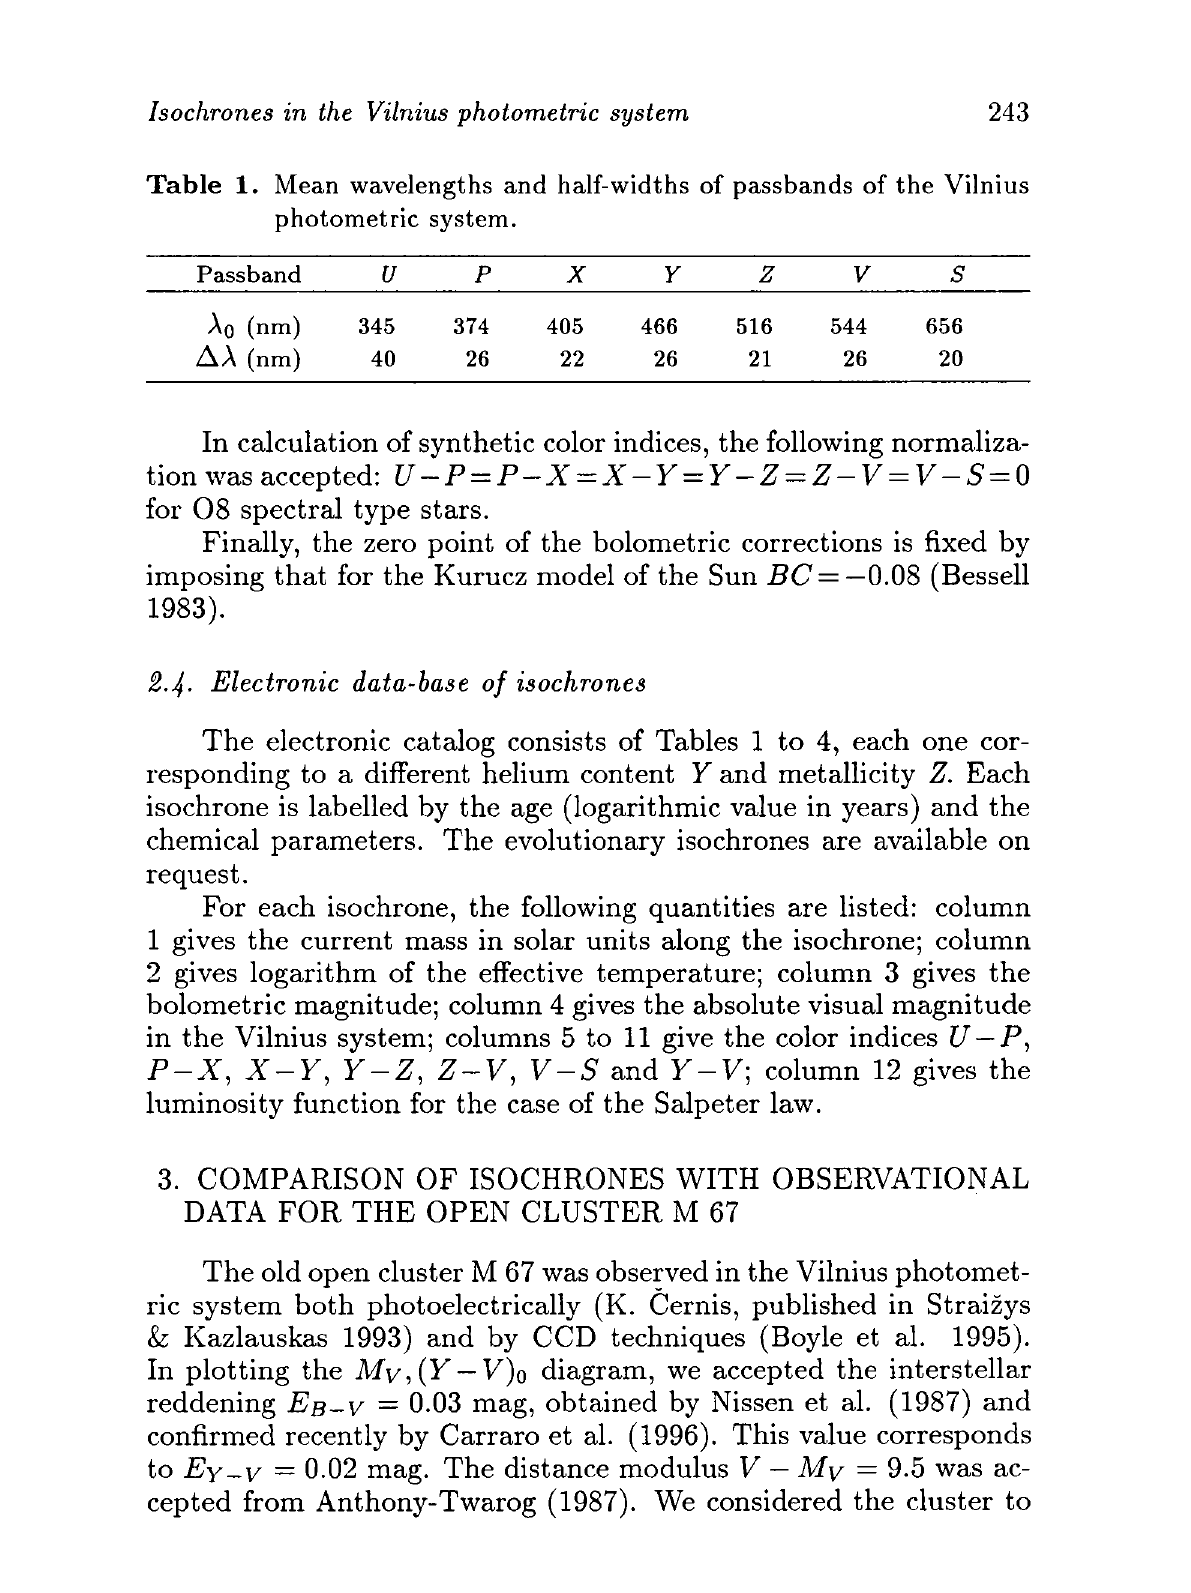
Table 1. Mean wavelengths and half-widths of passbands of the Vilnius photometric